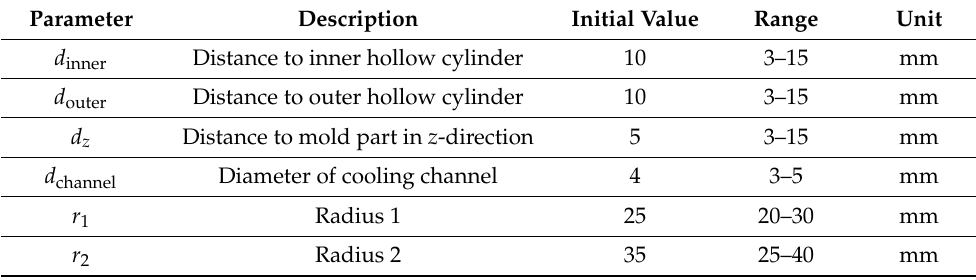
Table 4. Optimization parameters for the close-contour cooling